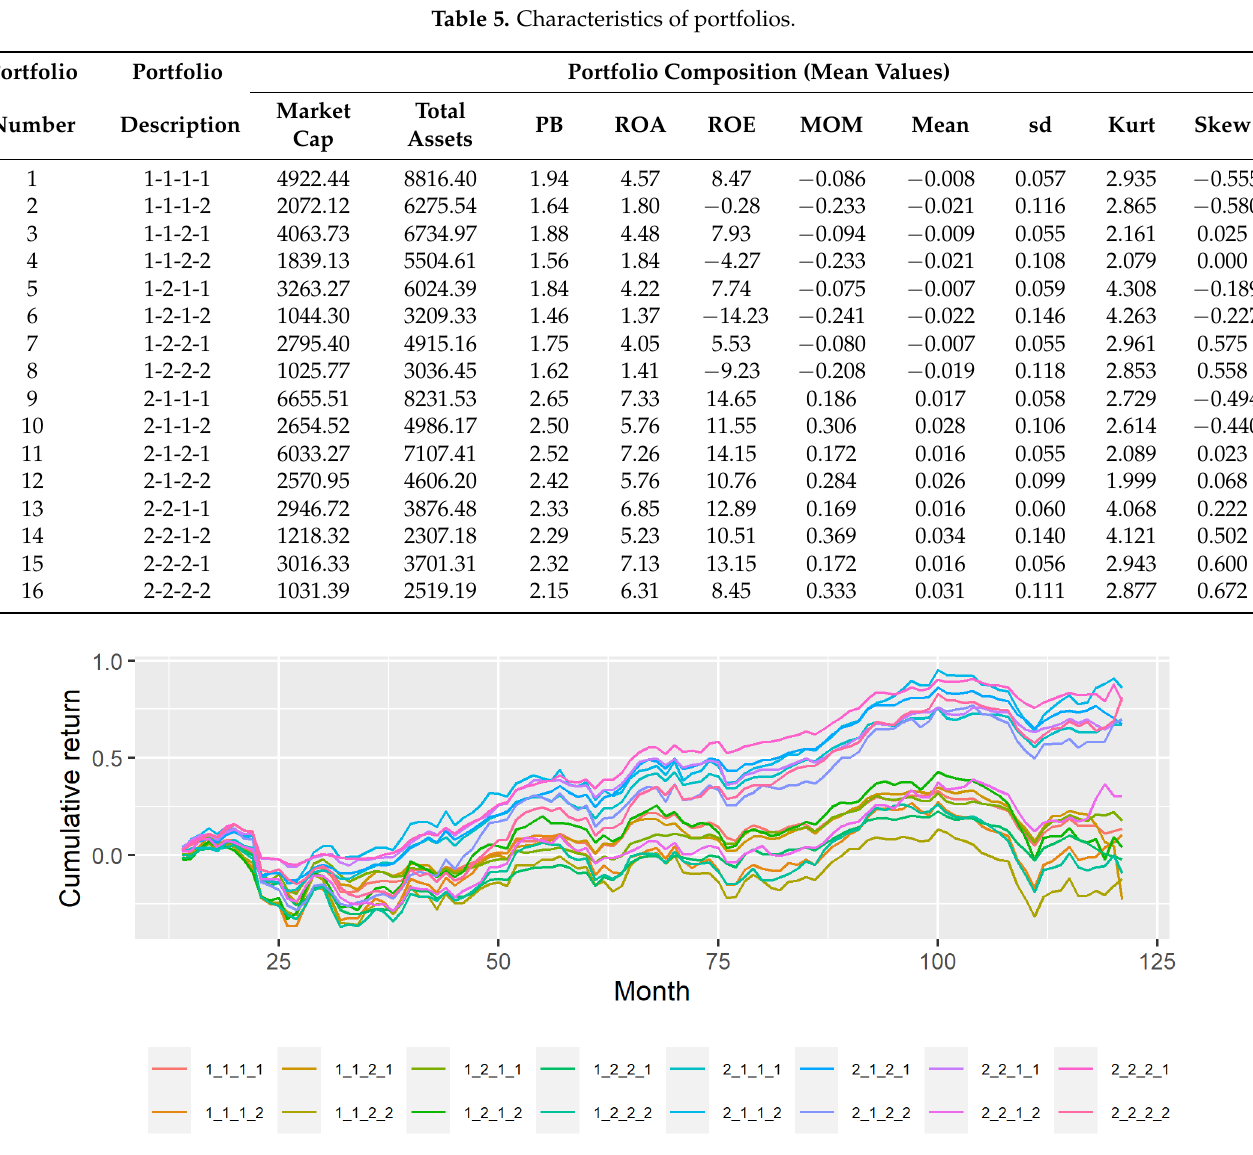
Table 5. Characteristics of portfolios.